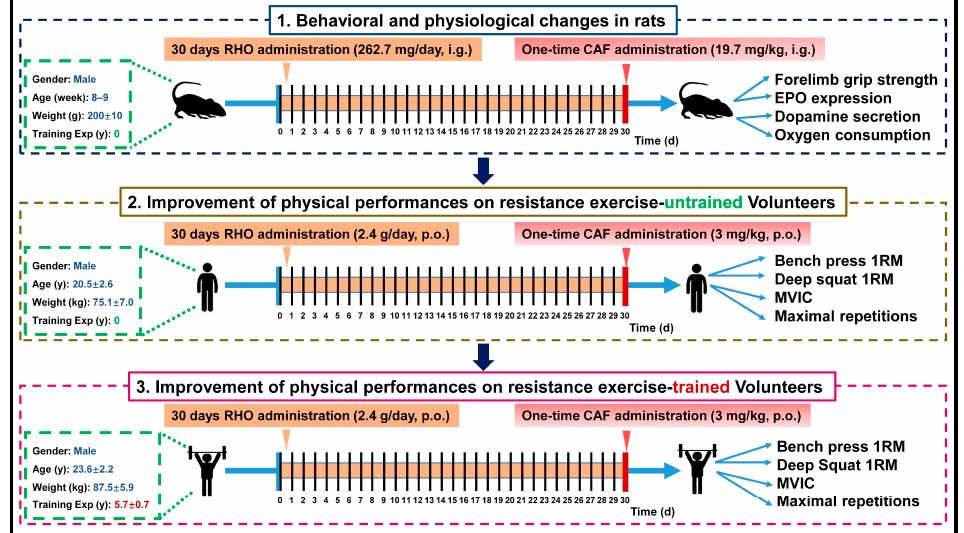
Figure 1. Schematic diagram of grouping, administration and experimental approaches. (1) Male SD rats were treated with 262.7 mg/kg Rhodiola rosea for 30 consecutive days with training and 19.7 mg/kg CAF on the last day, followed by measurement of relevant parameters (n = 12 × 4 groups = 48 samples). (2) Volunteers without resistance training experience committed to taking Rhodiola rosea for 30 days while participating in the training program. When the 30-day period ended, they took a single dose of 3 mg/kg CAF and then measured the relevant parameters (n = 12 × 4 groups = 48 samples). (3) Resistance exercise-trained volunteers with 5.7 ± 0.7-year of resistance training experi- ence took Rhodiola rosea for 30 days during their participation in the training program. When the 30 days ended, they took a one-time dose of 3 mg/kg CAF, followed by the measurement of the relevant indicators (n = 12 × 2 groups = 24 samples).